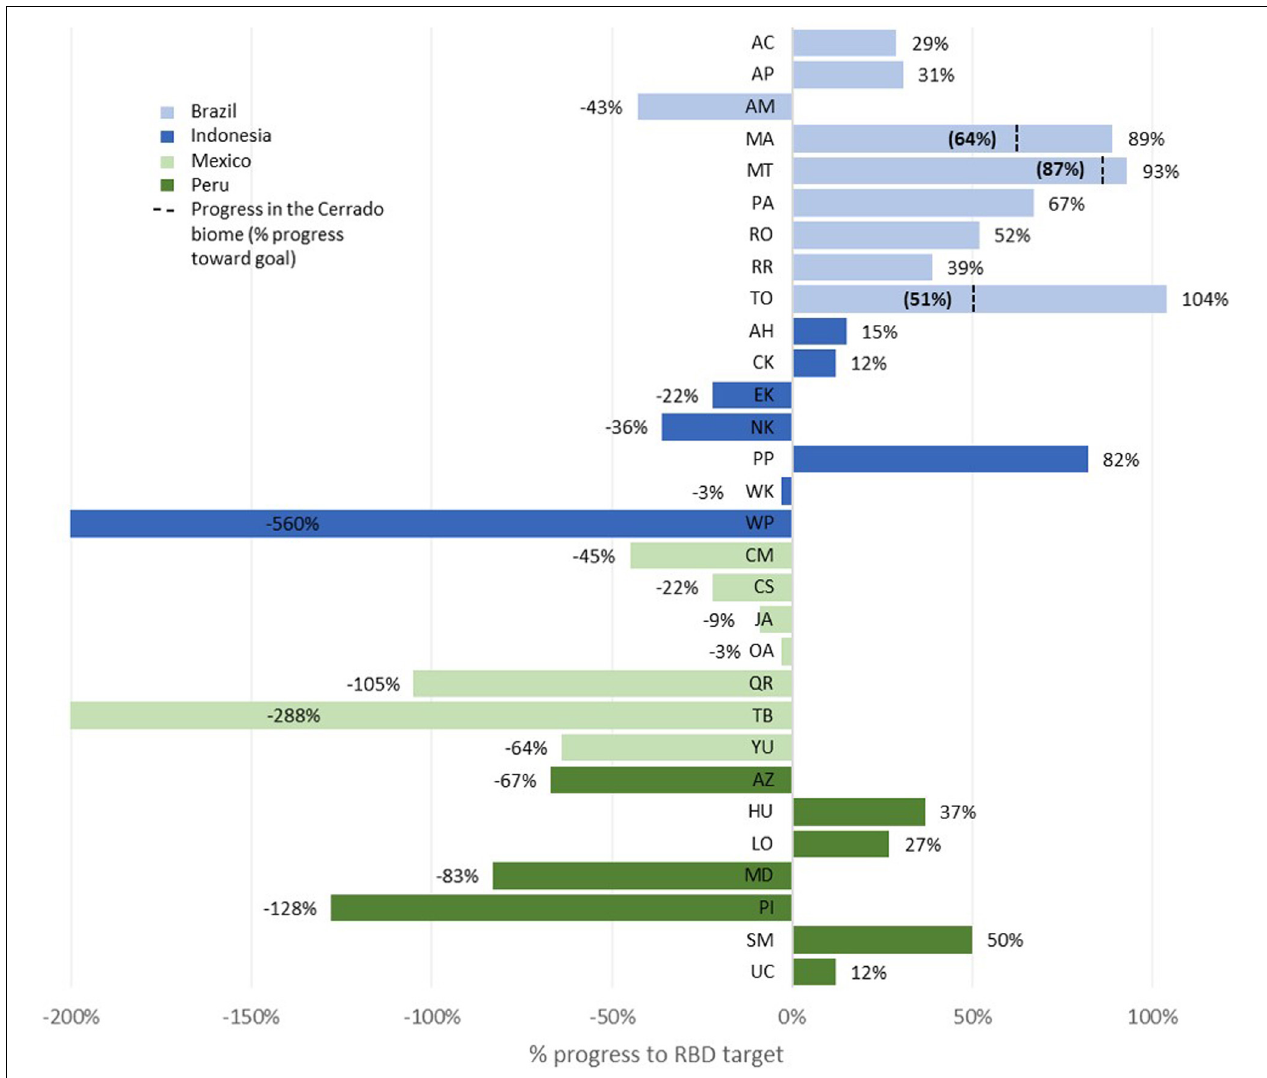
FIGURE 2 | Jurisdictions’ progress toward achieving the RBD deforestation reduction target as a percent of full compliance. A value of 100% or greater indicates that the RBD target has been reached or exceeded. A negative value indicates that the jurisdiction is increasing deforestation with respect to the baseline.